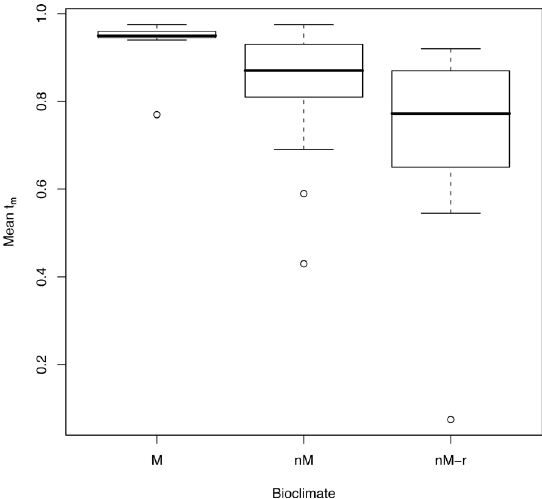
Fig. 4. Outcrossing rate variability among populations over three bioclimates (Mediterranean, M, non-Mediterranean, nM, and rear edge non-Mediterranean, nM-r) in Abies , Picea and Pinus species worldwide.